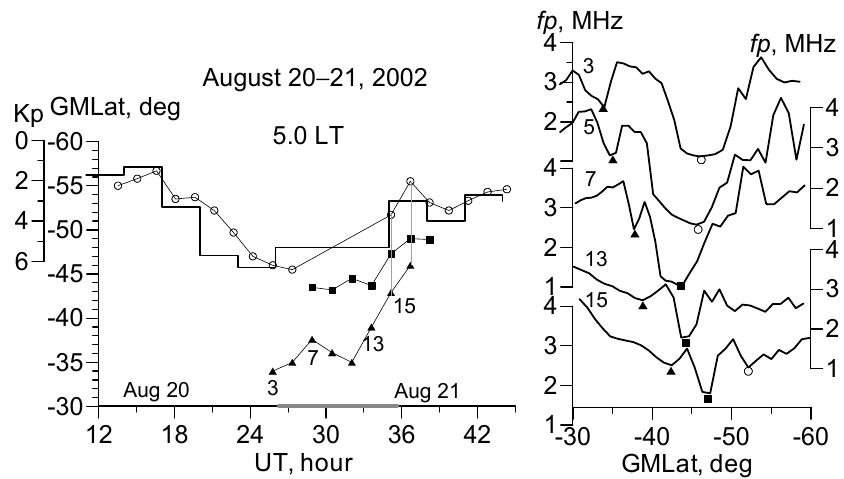
Figure 5. Variations in the troughs position during the 20–21 August 2002, in the Southern hemisphere at 5.0 LT. The designations are the same as in Figure 1. The time is counted from 12 UT on 20 August.